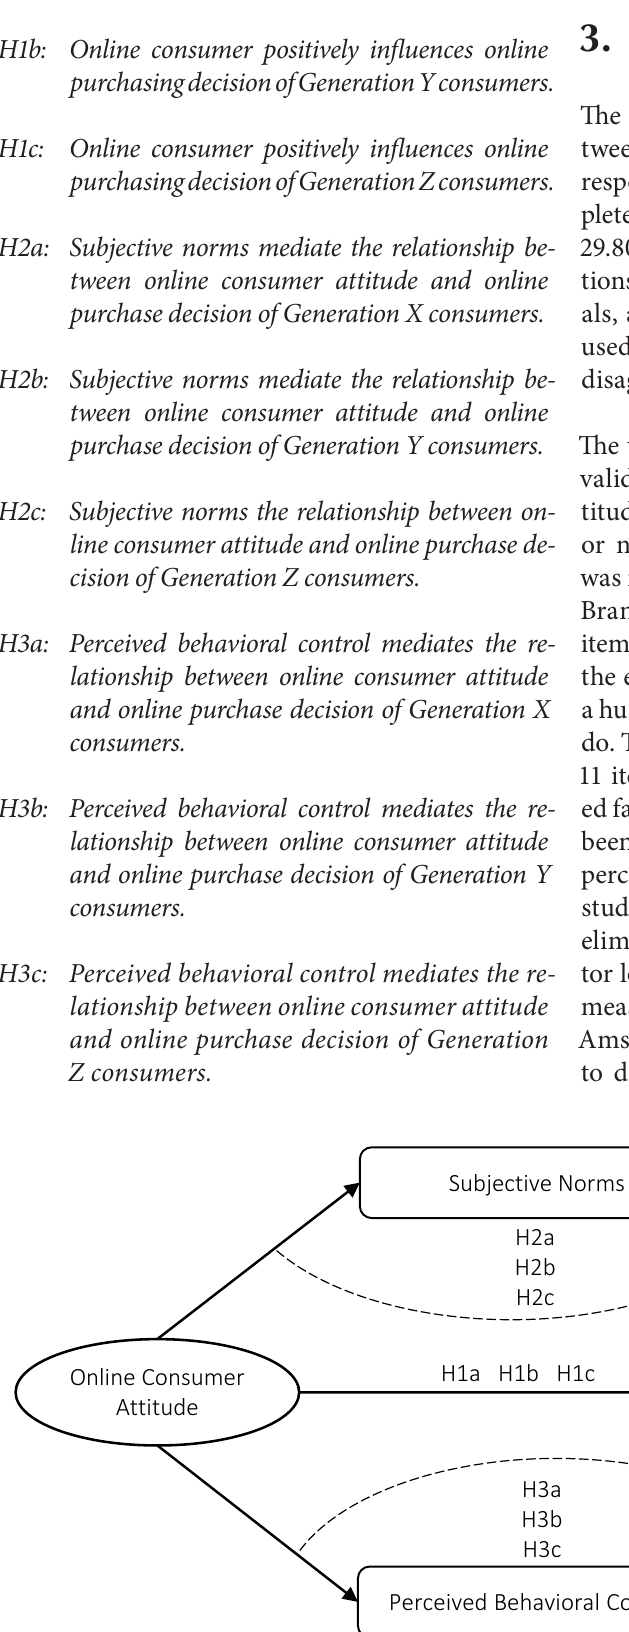
Figure 1. Theoretical research model